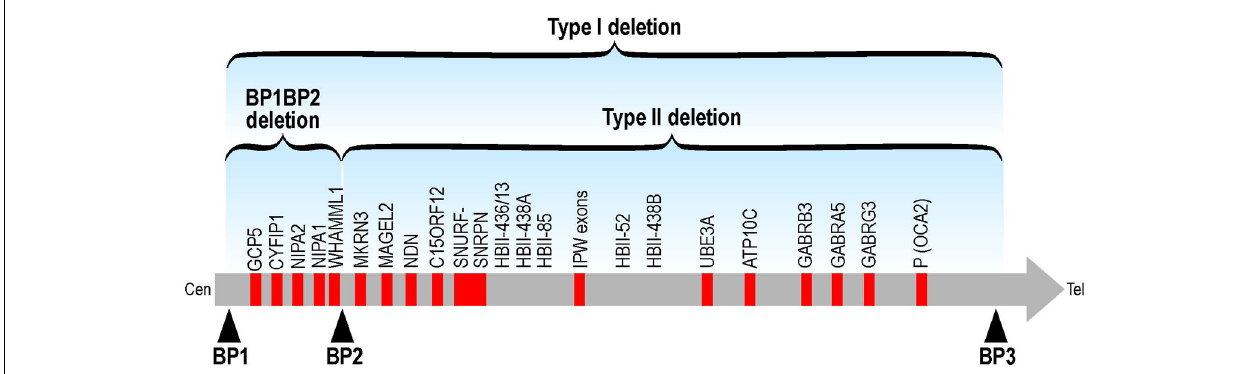
FIGURE 2 | Schematic representation ofTI andTII deletions at the chromosomic region 15q11-q13. The BP1-BP2 deletion (including CYFIP1 ) is located in